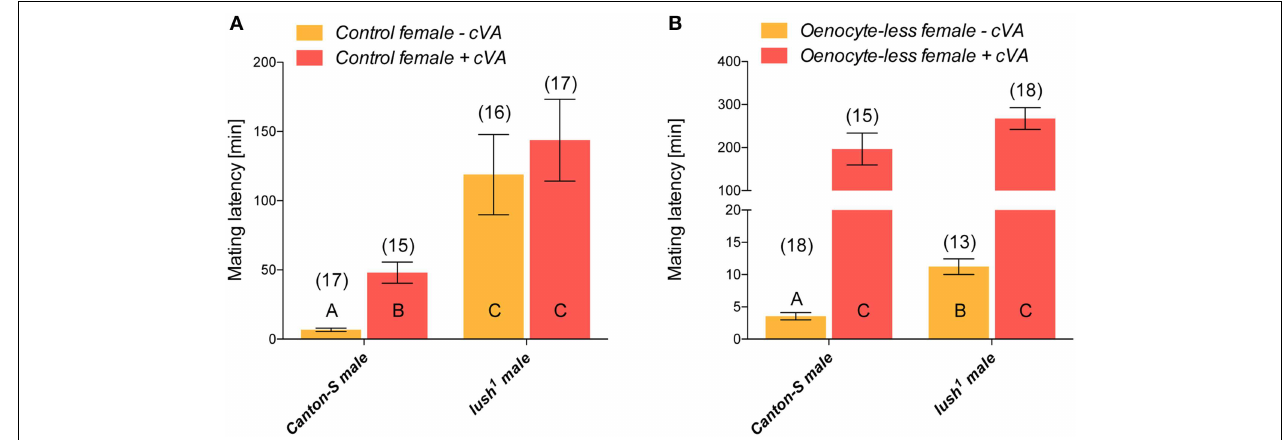
post-hoc test. (B) Mean mating latency in pairs consisting of 1 virgin male of the indicated genotype with one Oenocyte-less (Oe − ) female perfumed or not with 2000 ng of cVA. The number of replicates is indicated above the bar graphs. Error bars indicate Standard Error of the Mean (SEM). Bar graphs labeled with same letters are not significantly different from each other as determined by a One-Way ANOVA [ANOVA F (3 , 60) = 135 . 7 ; P < 0 . 0001 ] followed by Tukey post-hoc